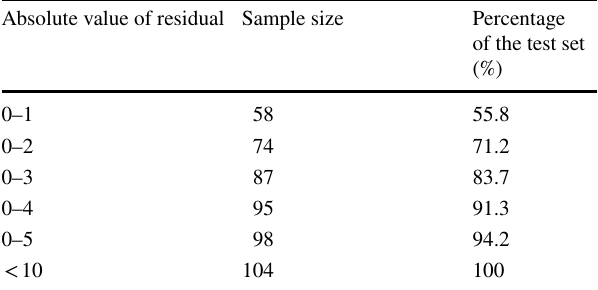
Fig. 14 MAE of the model predictions for different initial delay lengths 0.93